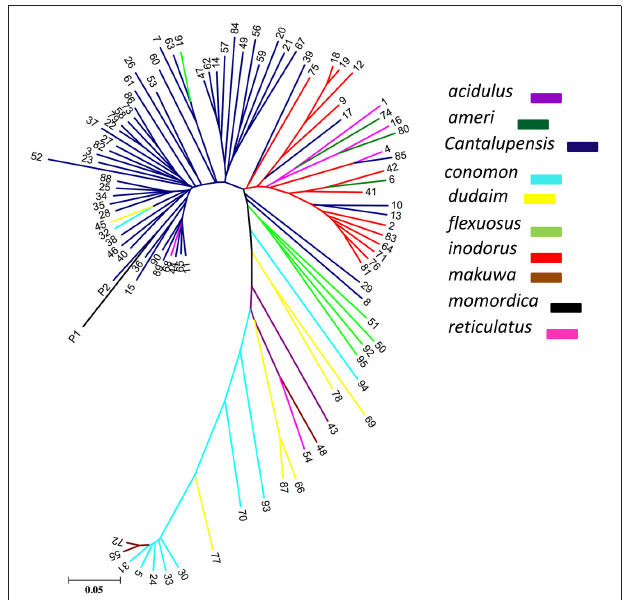
FIGURE 1 | Phylogenetic tree constructed with